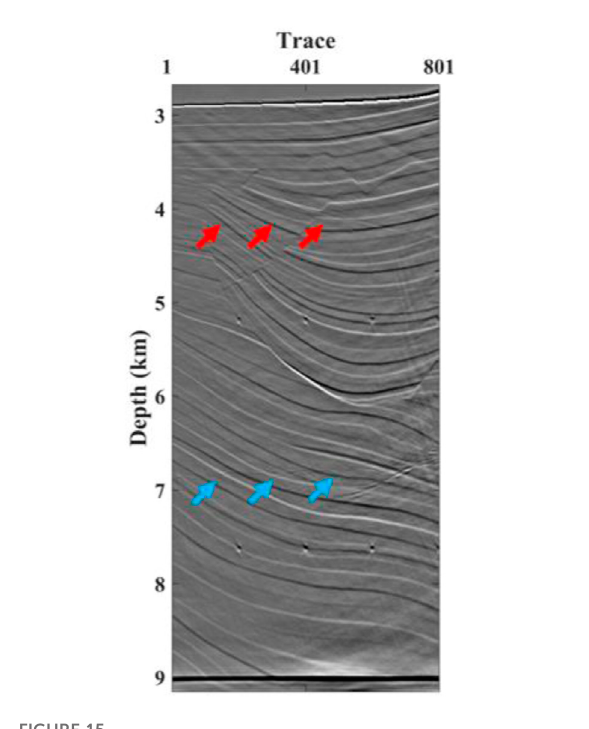
FIGURE 15 Denoised migration result. The red and light blue arrows mark the positions of the two types of crosstalk before being